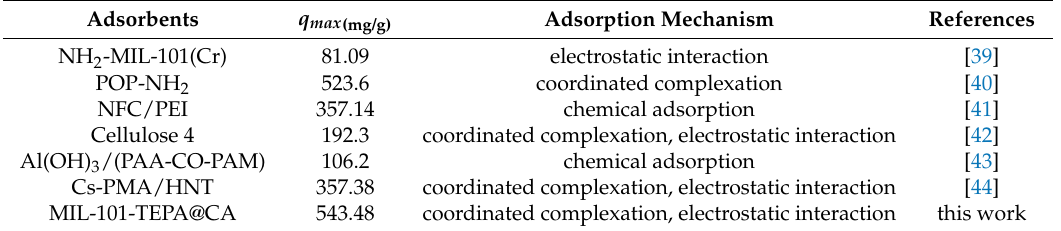
Table 3. Comparison of the maximum adsorption capacity for Pb(II) with reported adsorbents. Adsorbents q max